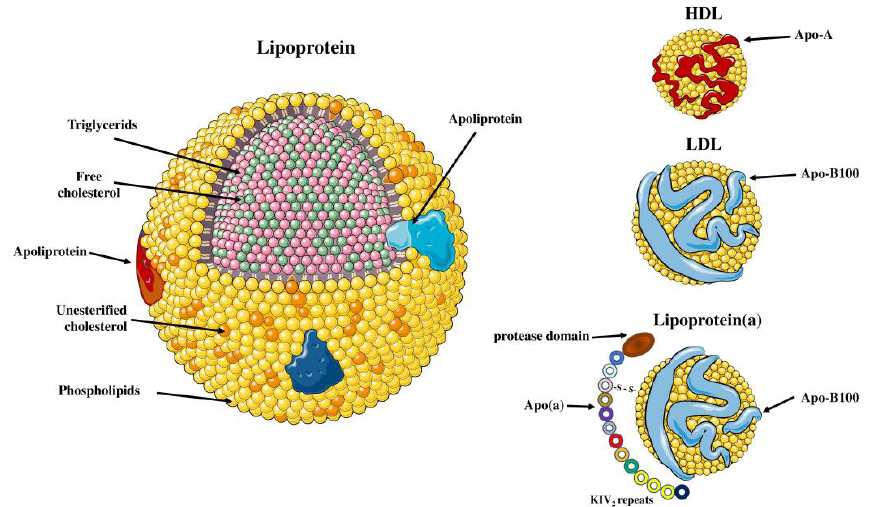
Figure 2. Differences between Lp(a), LDL and HDL. Lipoprotein(a) is composed of one LDL particle containing apo-B100 and apo(a). HDL is composed of a high-density lipid core, and the most common apolipoproteins found on its surface are apo A-I and apo A-II. Parts of the figure were drawn by using pictures from Servier Medical Art. Servier Medical Art by Servier is licensed under a Creative Commons Attribution 3.0 Unported License (https://creativecommons.org/licenses/by/3.0/) (accessed on 4 November 2022).